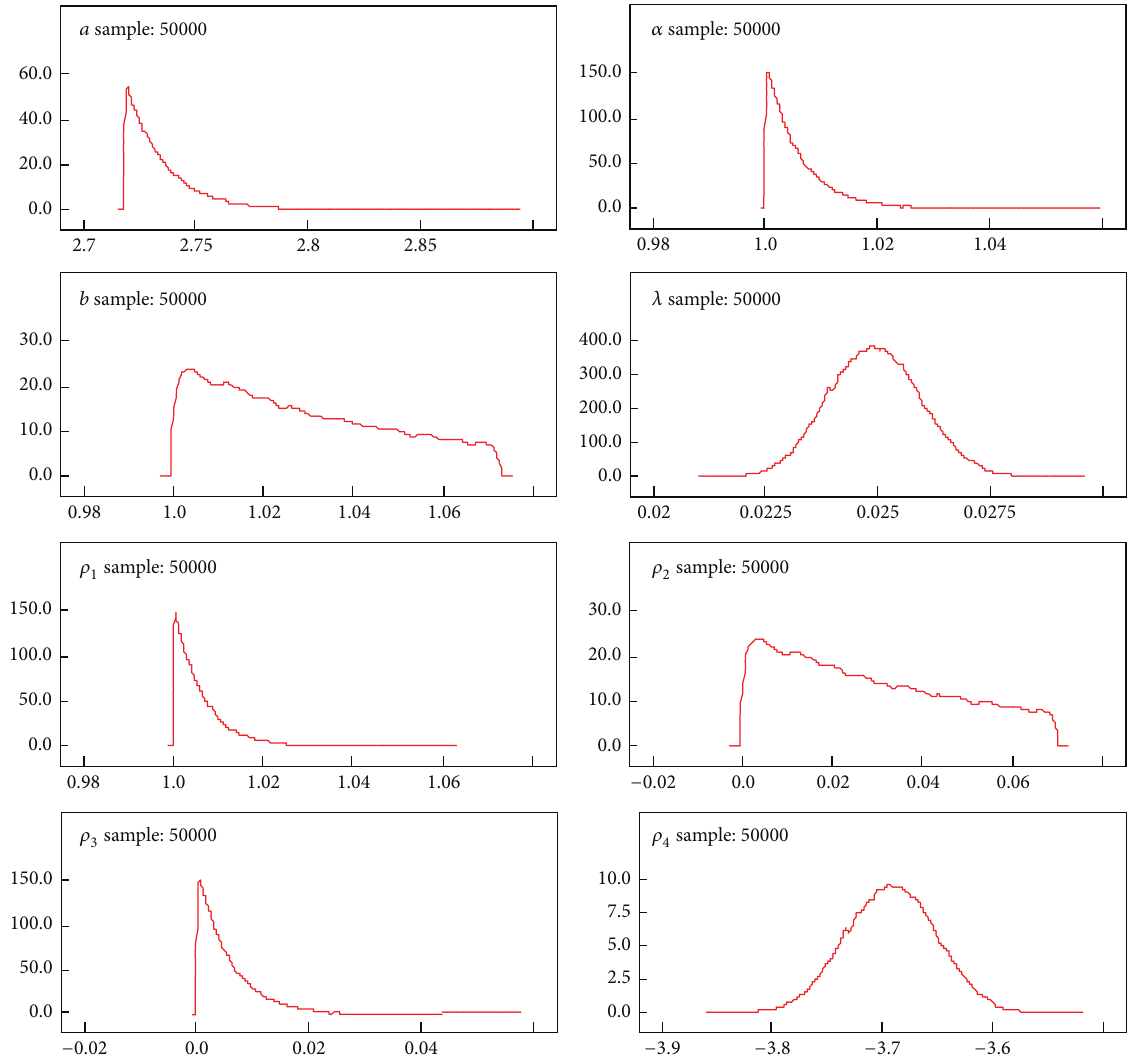
Figure 5: Kernel density of the posterior parameters in the case of beta generalized exponential for Black Hispanic females breast cancer patients ( 𝑛 = 298